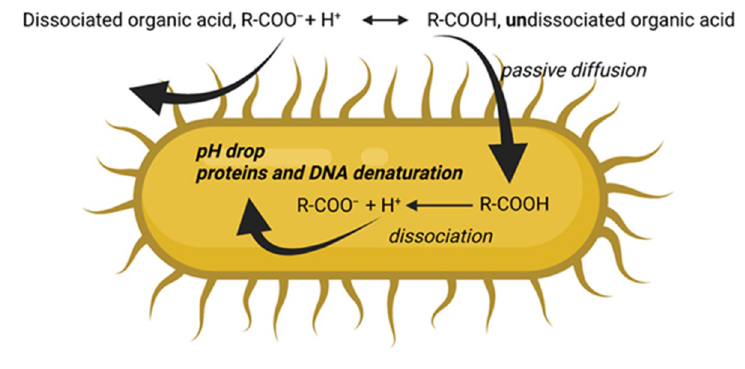
Figure 4. Example of organic acids’ antimicrobial mechanism of action.